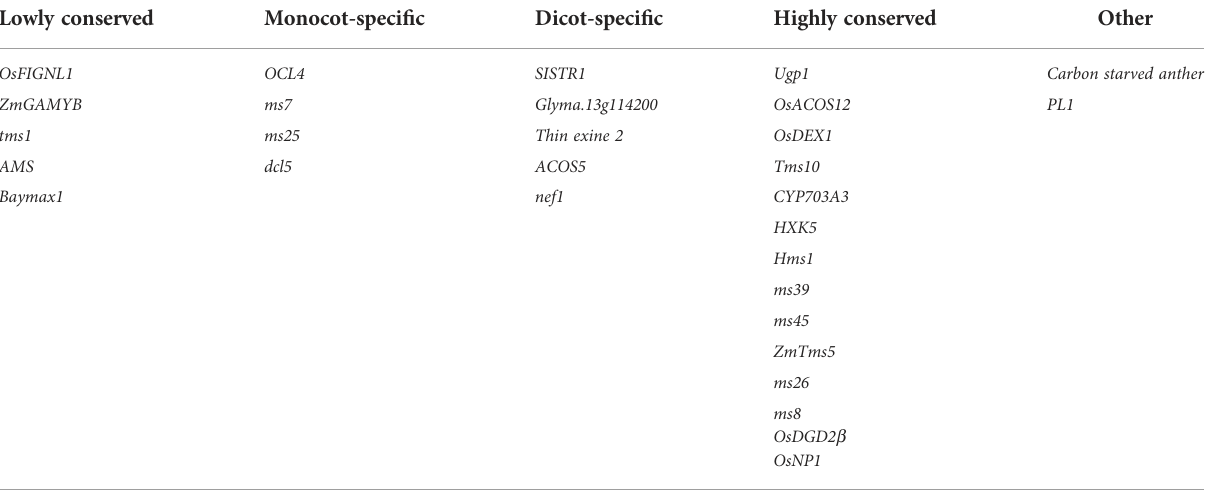
TABLE 1 Homology-based comparison of thirty known male sterility